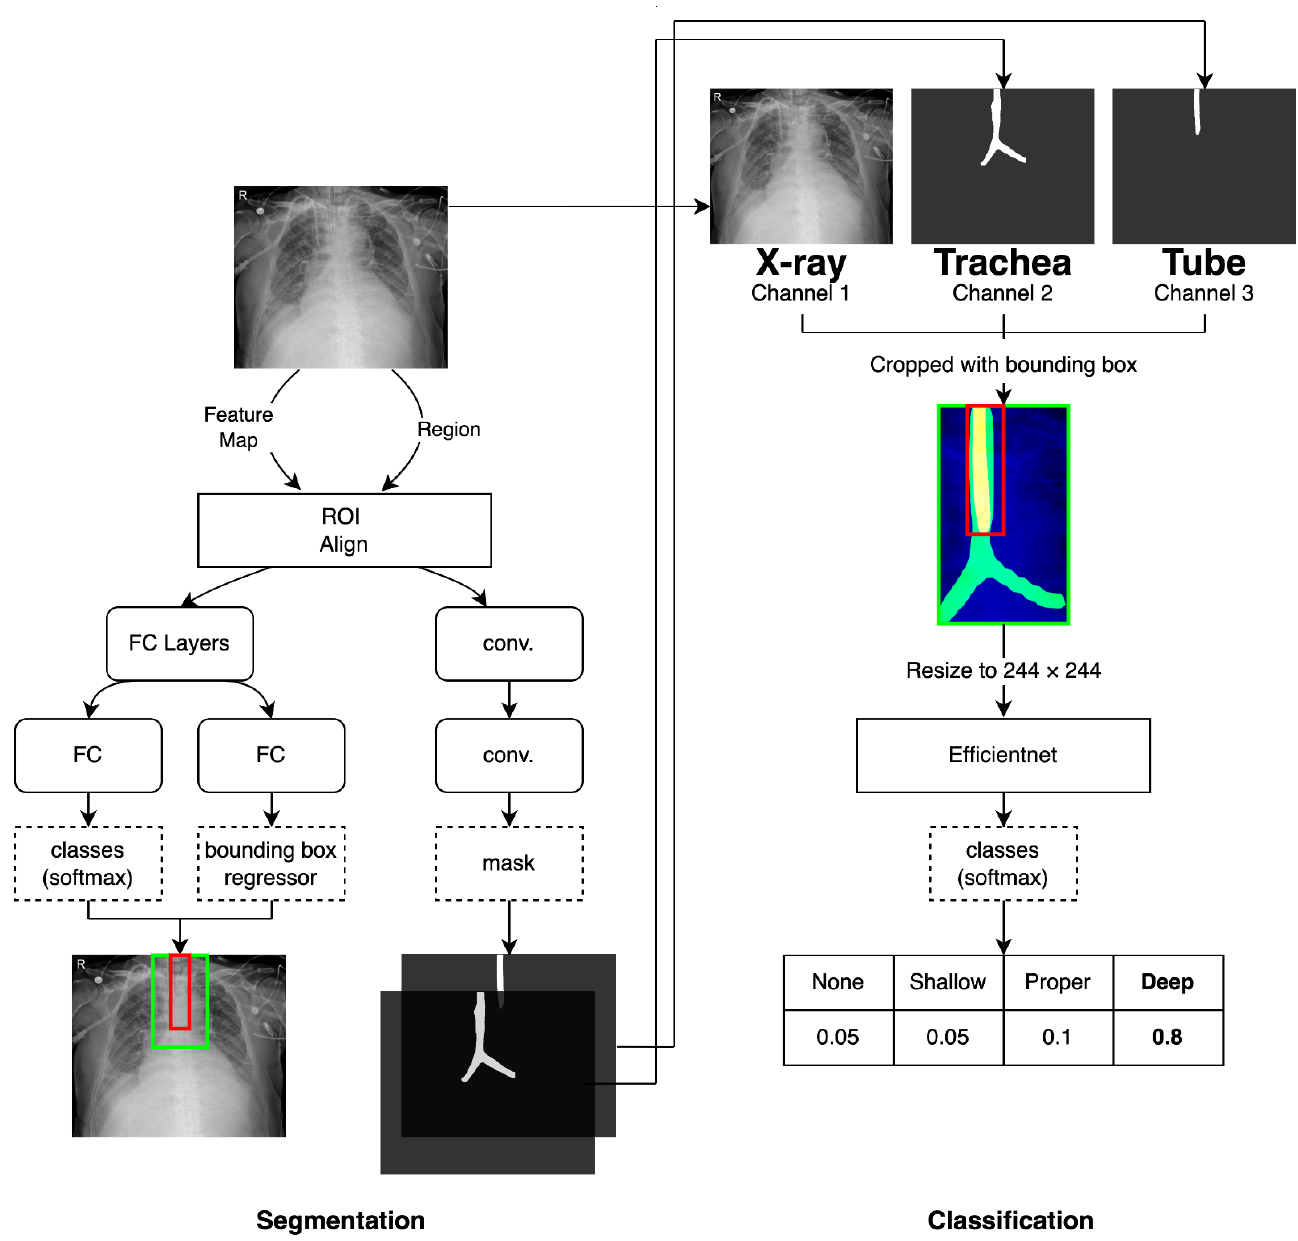
Figure 3. Overall flow of network architecture for segmentation of the trachea and ETT and for multi-label classification for proper position of the ETT in trachea. Mask R-CNN outputs segmentation results and bounding boxes. These results were fed into Efficientnet as an additional input to improve the multi-label classification accuracy. FC, fully connected layers.